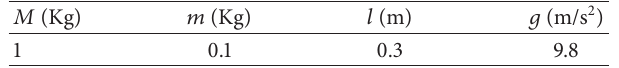
Table 1: Inverted pendulum